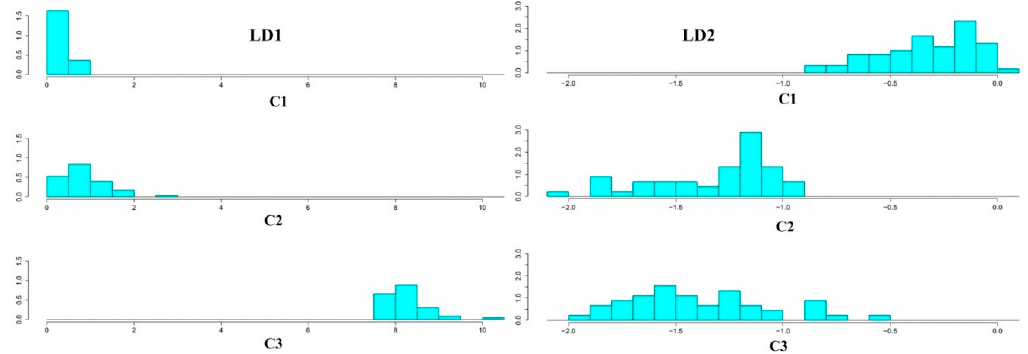
Figure 6. Histogram plots for first 10 features based on discriminant functions (LD1 and LD2).